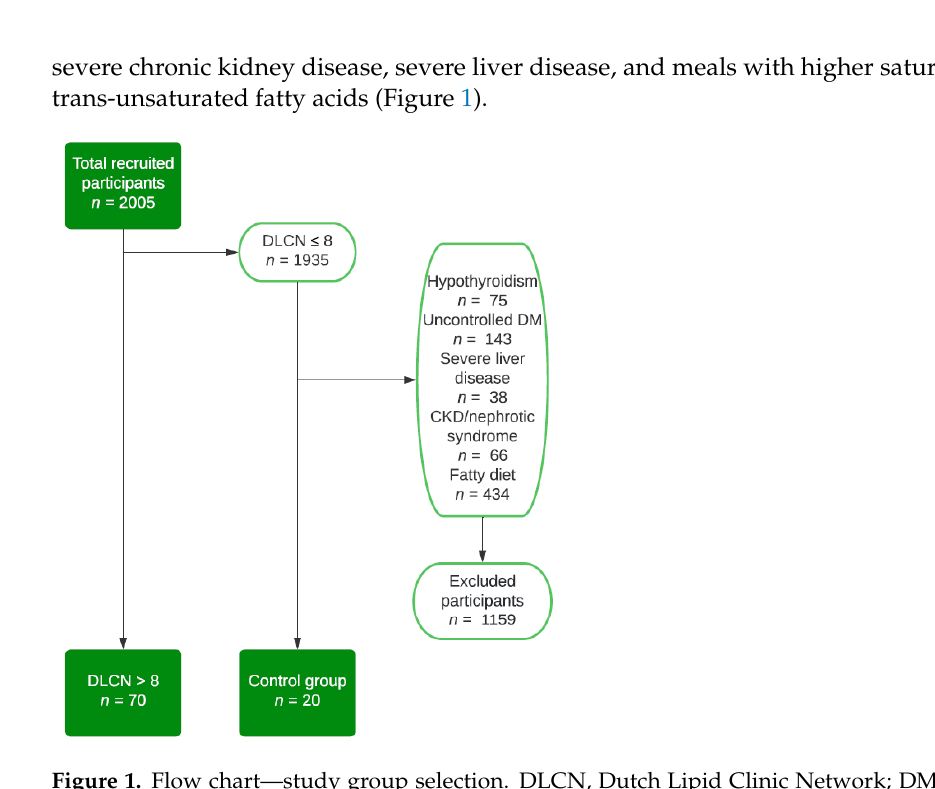
Figure 1. Flow chart—study group selection. DLCN, Dutch Lipid Clinic Network; DM, diabetes mellitus; CKD, chronic kidney disease.